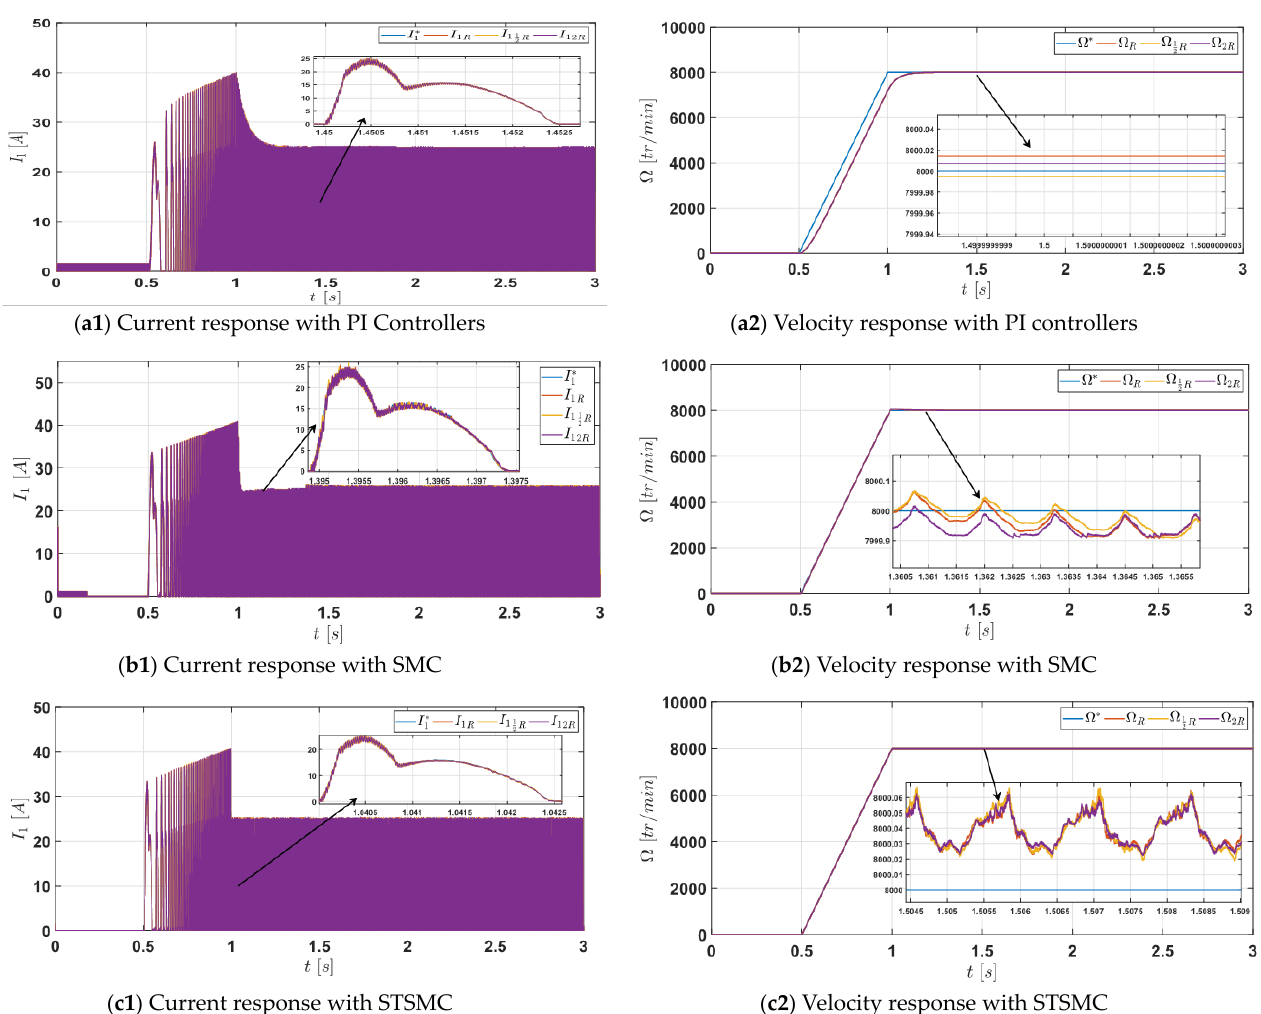
Figure 7. Velocity and current responses with the three controllers